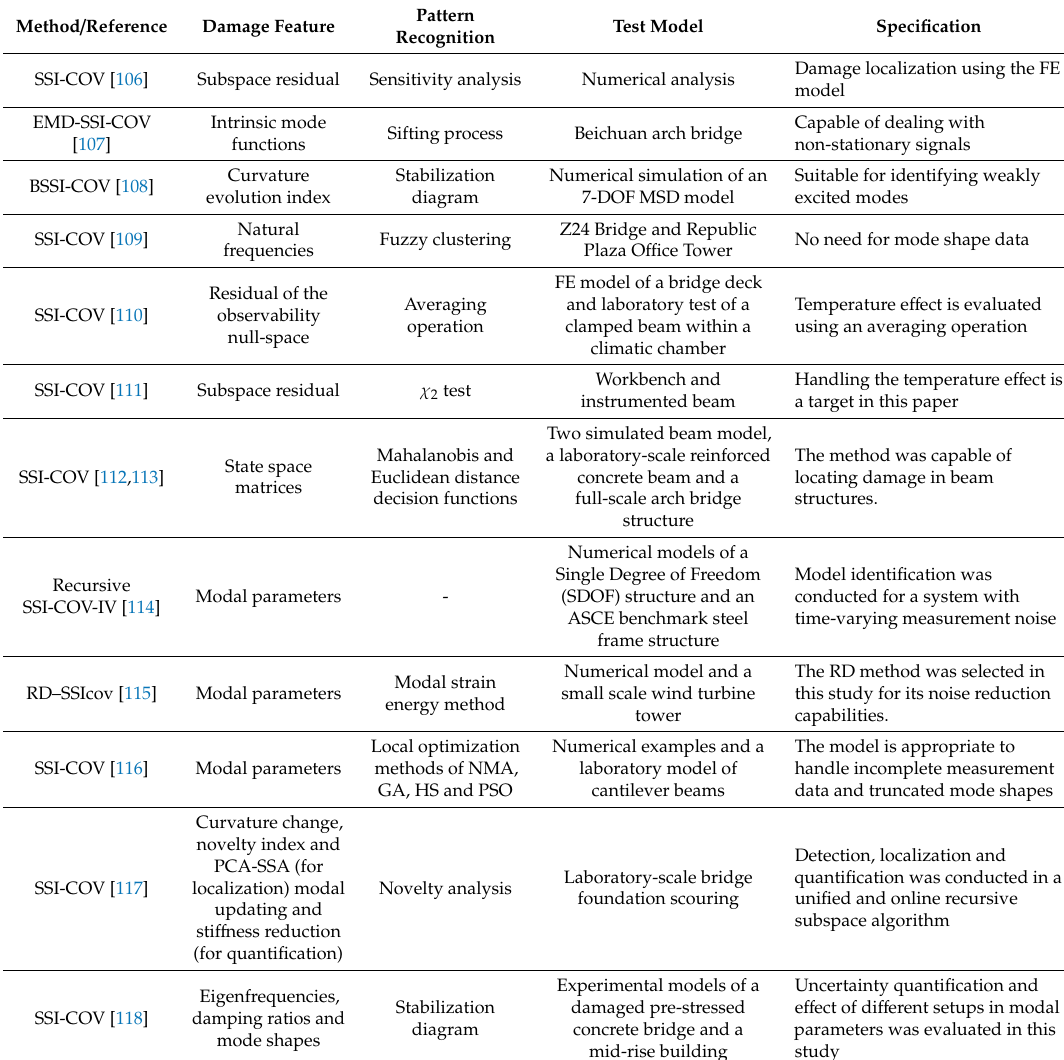
Table 4. Some examples of the schemes that use covariance-driven subspace system identification (SSI-COV) in their damage identification